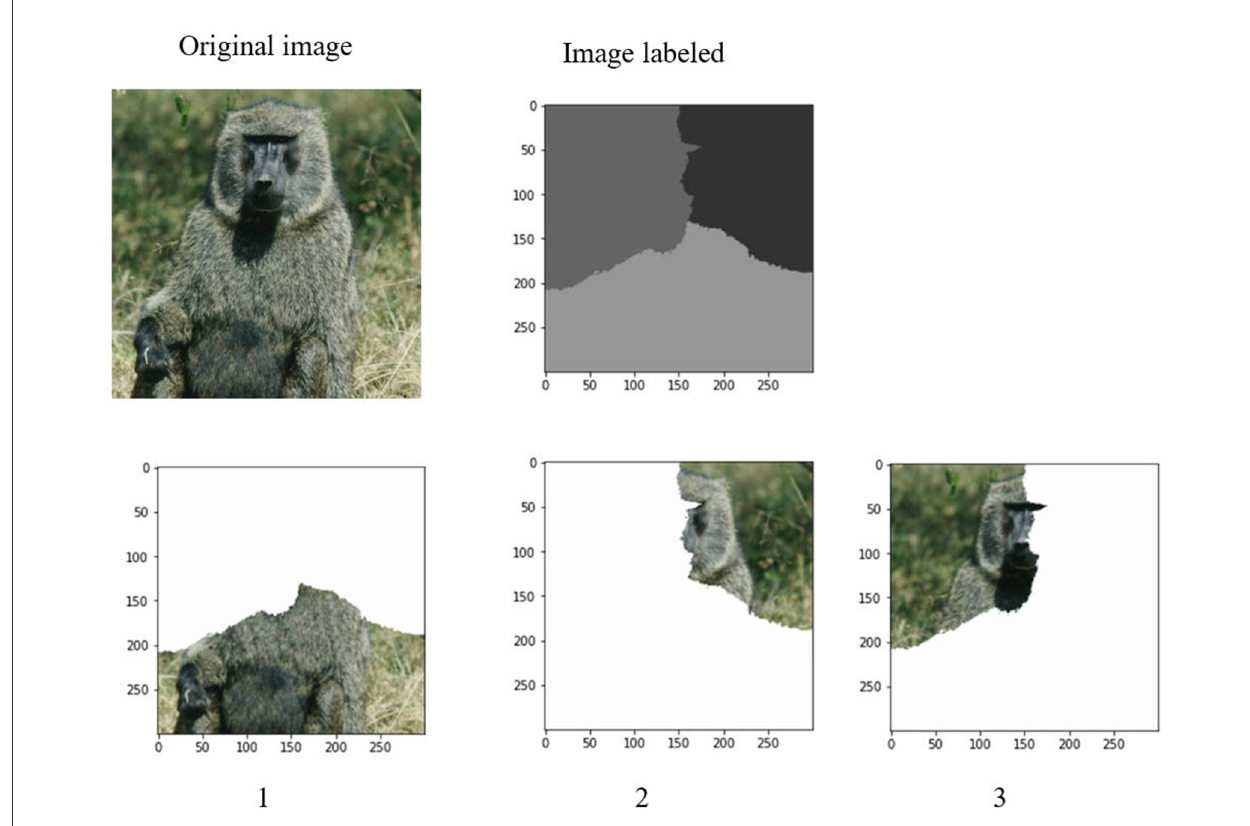
FIGURE7 Grouping on the eigenvalue by FCM to k